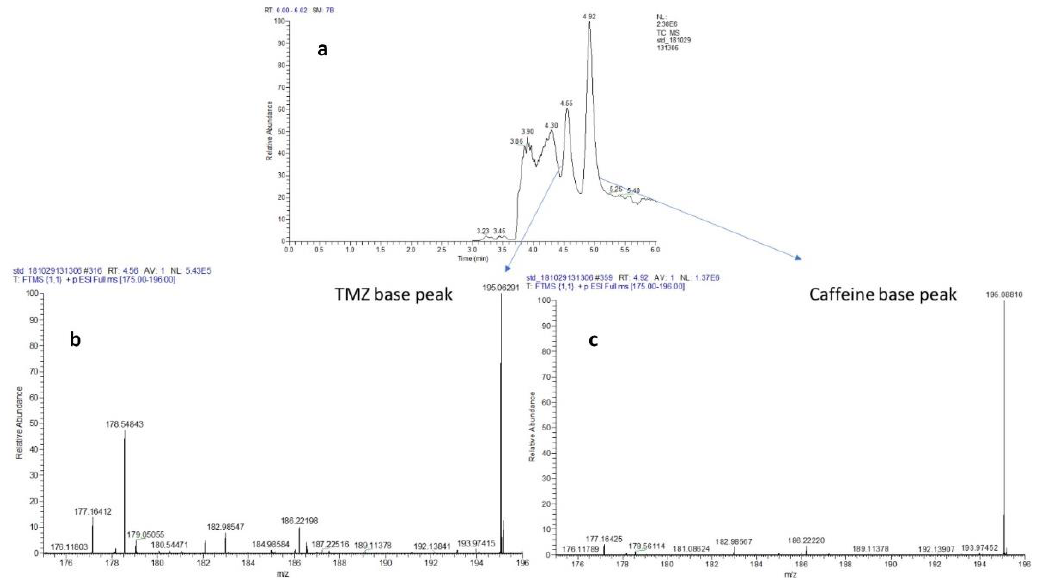
Figure 3. ( a ) Separative total ion chromatogram (TIC) of TMZ in presence of caffeine, as an internal standard on C18 HILIC column with 30:70 Water (0.1% FA): ACN (0.1% FA). ( b ) Parent ion or mass peaks for TMZ. ( c ) Molecular ion peak for caffeine as internal standard.